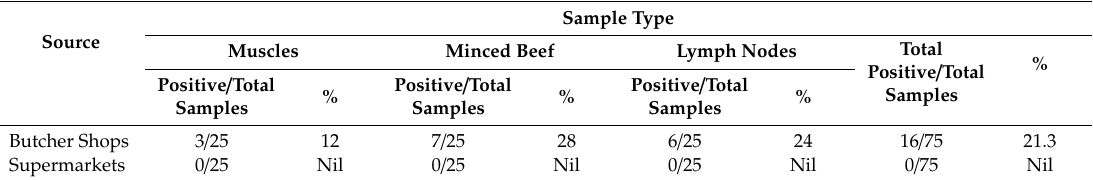
Table 1. Prevalence of Salmonella spp. in raw beef meat samples sold at butcher shops and supermarkets.